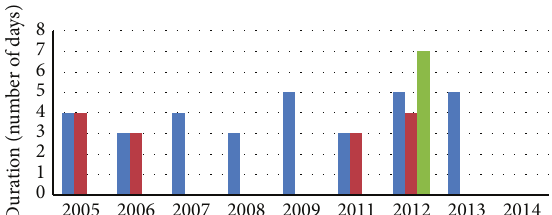
Figure 2: Yearly number (number of columns in each year) and duration ( 𝑦 -axis) of identified heat-wave events in Spain in the period of 2005–2014 (source: State Meteorology Agency (AEMET),